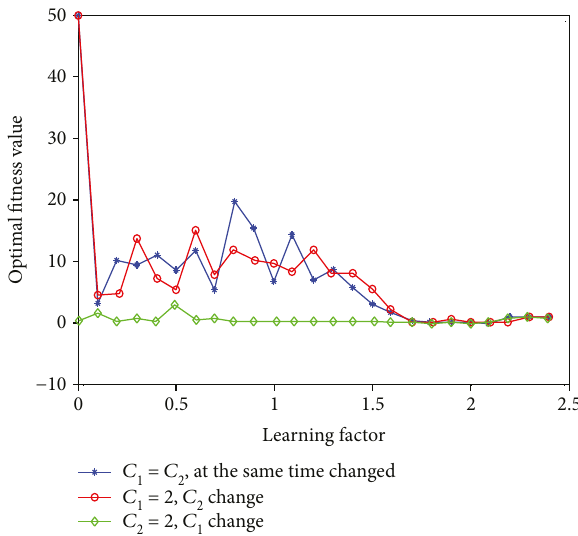
Figure 11: The e ff ect of maximum speed on algorithm